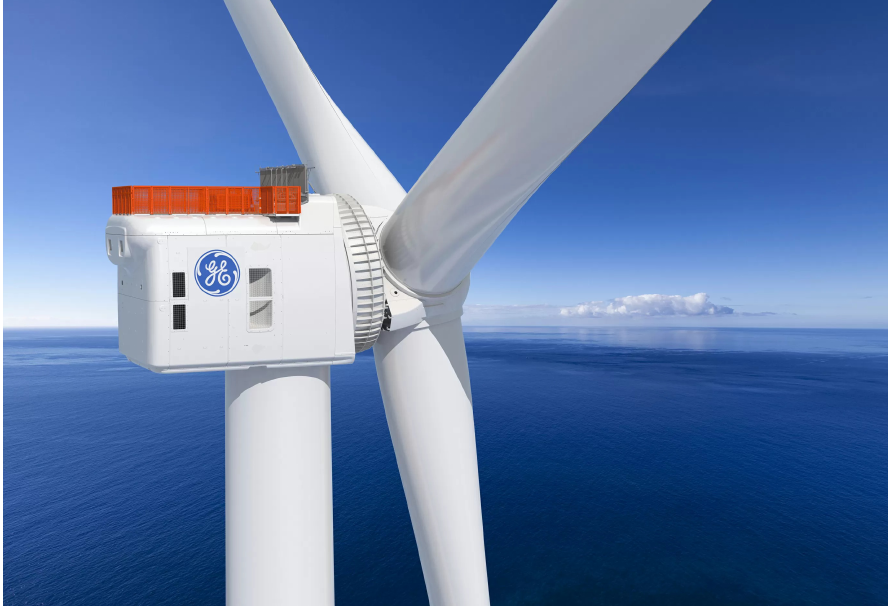
Figure 8. Haliade-X prototype (Reprinted with permission from [57]. 2022,